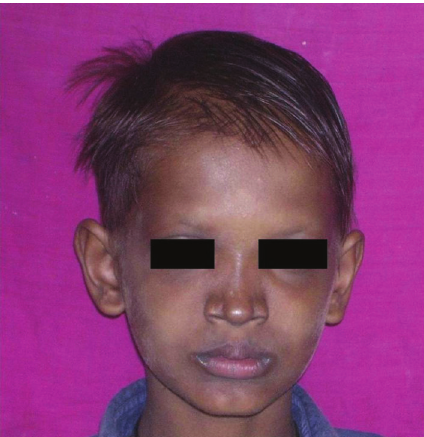
Figure 1: Pretreatment extraoral view.